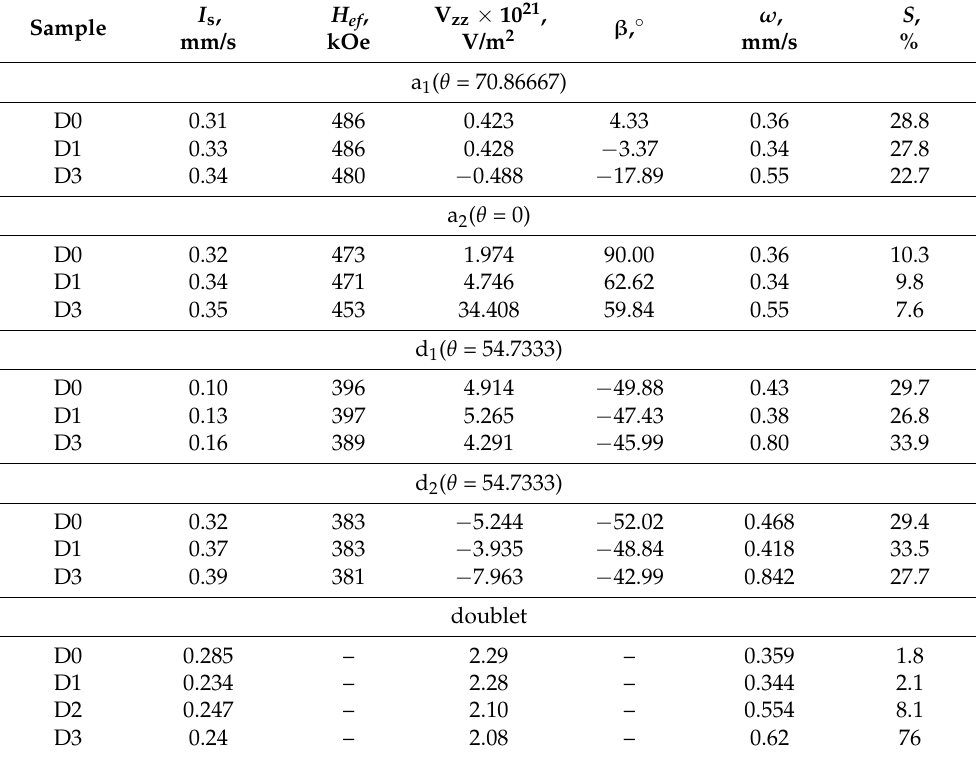
Table 2. Fitting parameters of Mössbauer spectra for YIG films implanted with Ne + ( E = 82 keV, δ —isomeric shift, H ef —effective magnetic field on the Fe 57 nucleus, U zz —axial components of the electric field gradient tensor, β —the angle between H ef and U zz , ω —linewidth, S —integral intensity of the spectra component, θ —the angle between H ef and